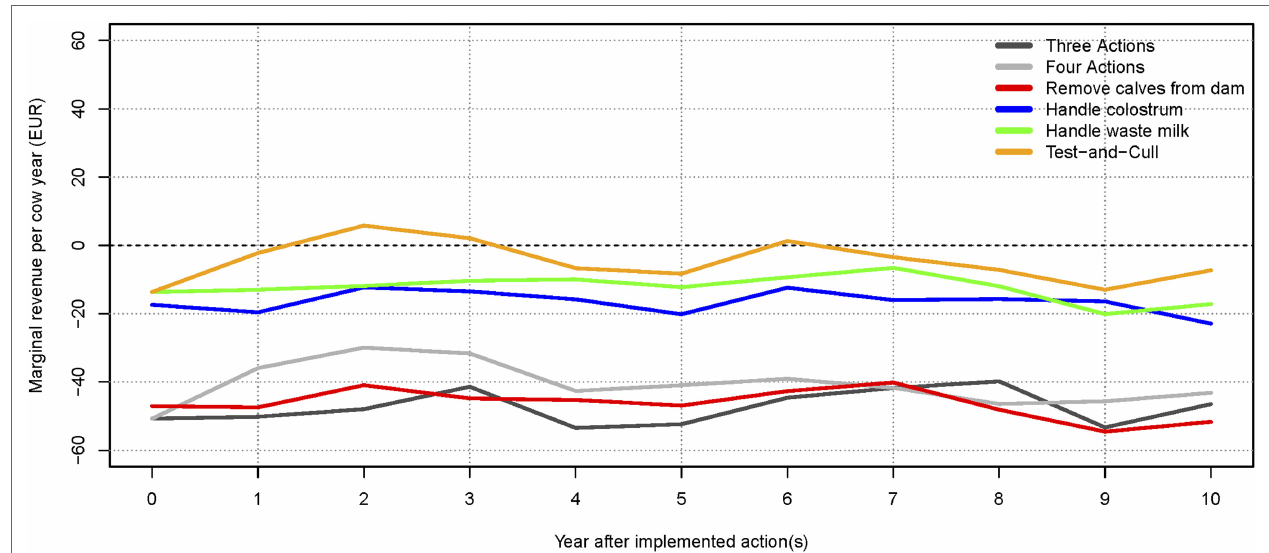
FIGURE 3 | Change in net revenue per cow year over time for the average-hygiene herd, relative to the baseline scenario . The marginal for each action and combinations are shown. The dotted line (at 0 A C) represents the baseline scenario (no